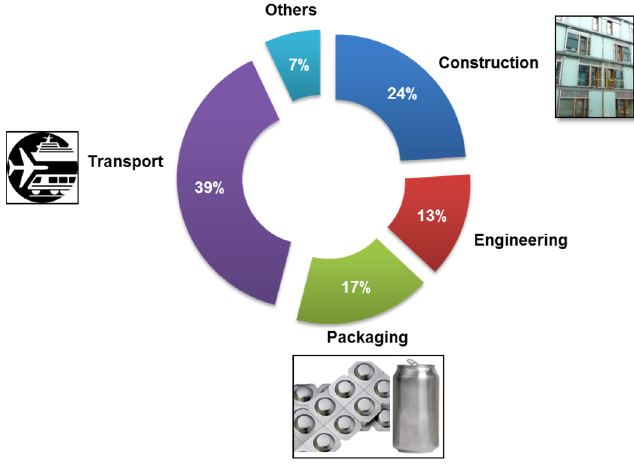
Figure 6. Main end ‐ uses for aluminum products in Europe (data from 2013). Adapted from